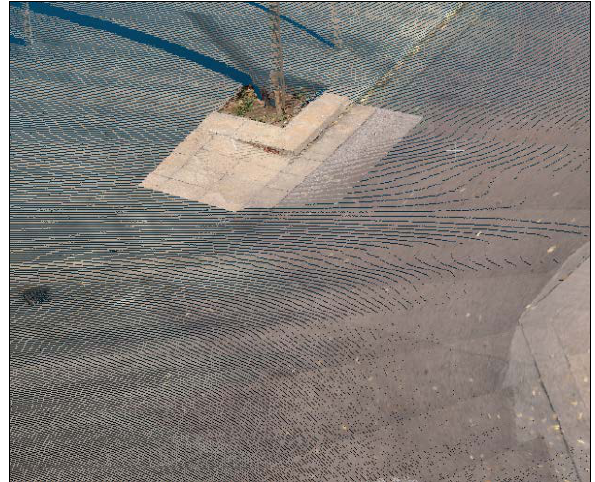
Figure 4. Mobile mapping system based (all area) vs camera based point clouds (curb ramp